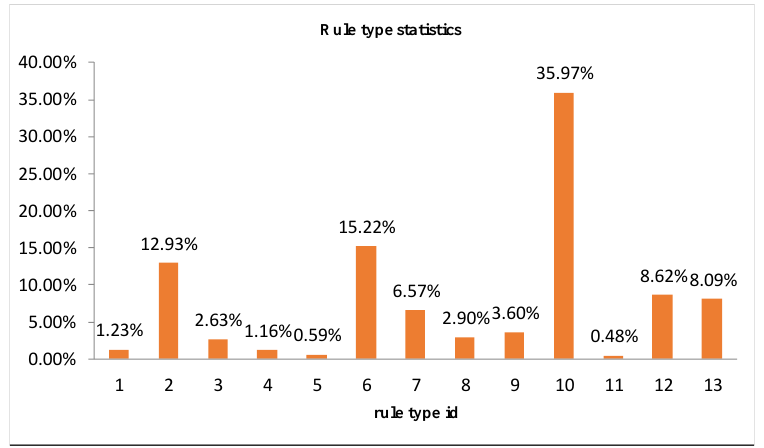
Figure 5. Statistics on the percentage of adversarial example transformation